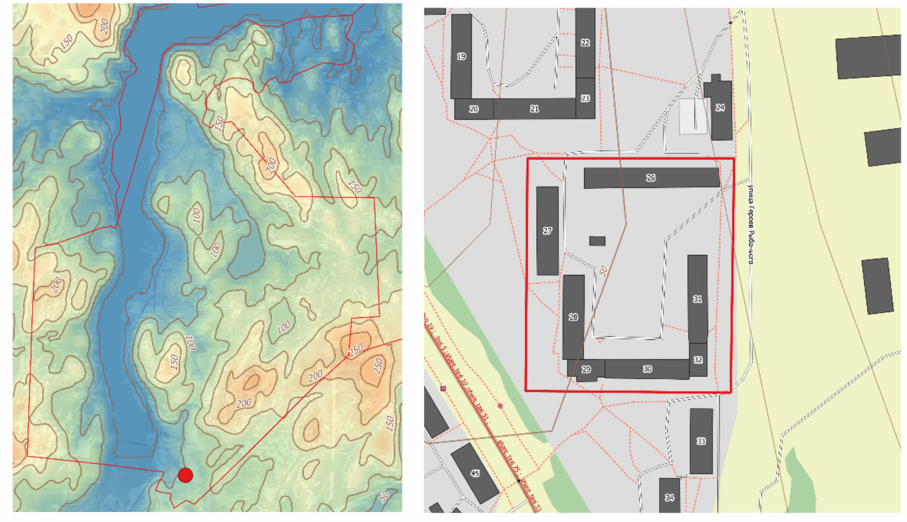
Figure 7. Situational plan of the area under consideration, indicating the contours of the relief.